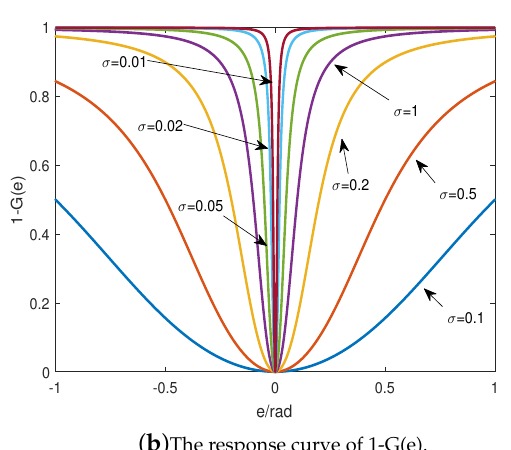
Figure 3. Smooth-switching function